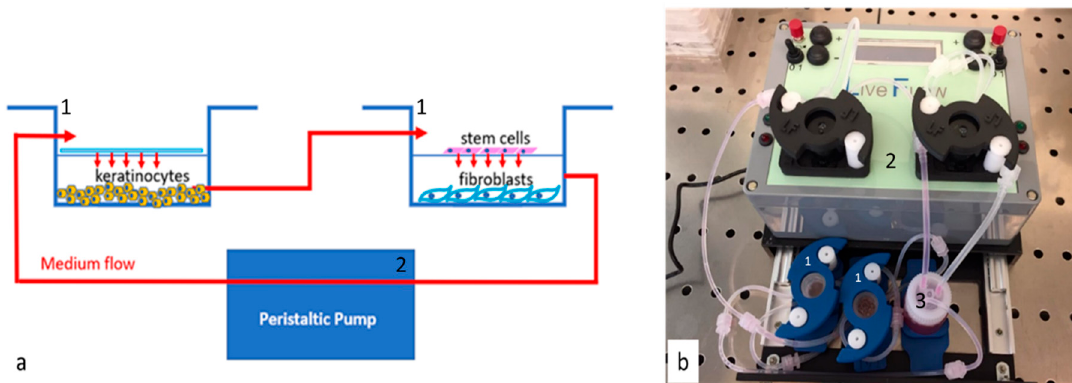
Figure 1. Scheme ( a ) and picture ( b ) of bioreactor. Panel a represent the chambers (Live Box2; blue (1)) and the cells cultured in every chamber. The chamber and the pump (Live Flow (2)) connections are visible by medium flow (red lines and arrows in the scheme). Panel b is the picture of the bioreactor used (IVTech) the chambers Live Box2 are blue (1); number (2) indicates the pump and number (3) the reservoir for the culture medium.